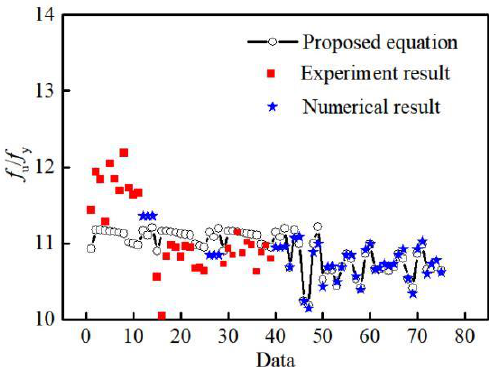
Figure 22. Comparison of the proposed equations with the results of test and numerical analysis.